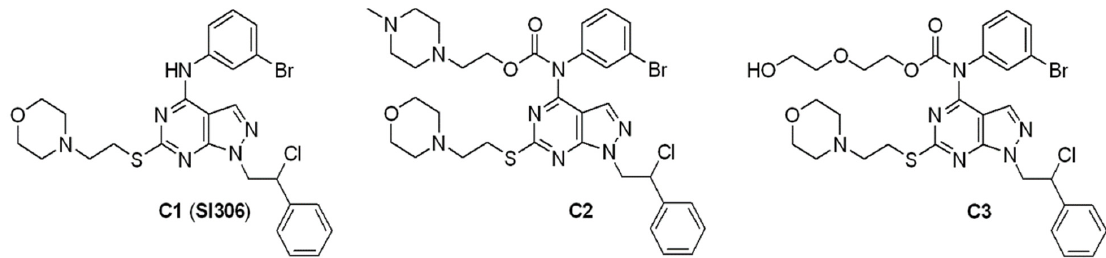
Figure 1. Structures of C1, C2, and C3.